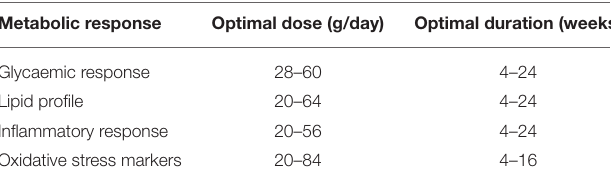
TABLE 2 | Appropriate dose and duration of mixed nut consumption to insert metabolic efficacy. Metabolic